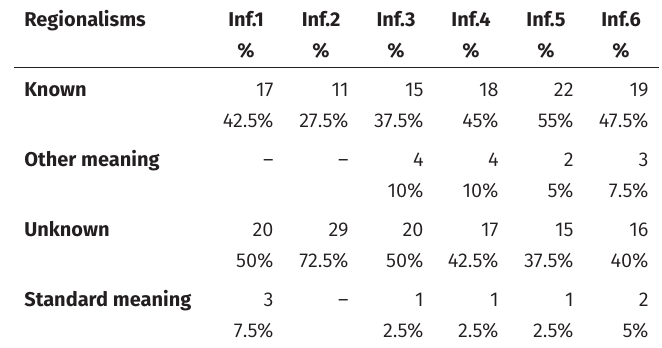
Table 4: Results from Câmara de